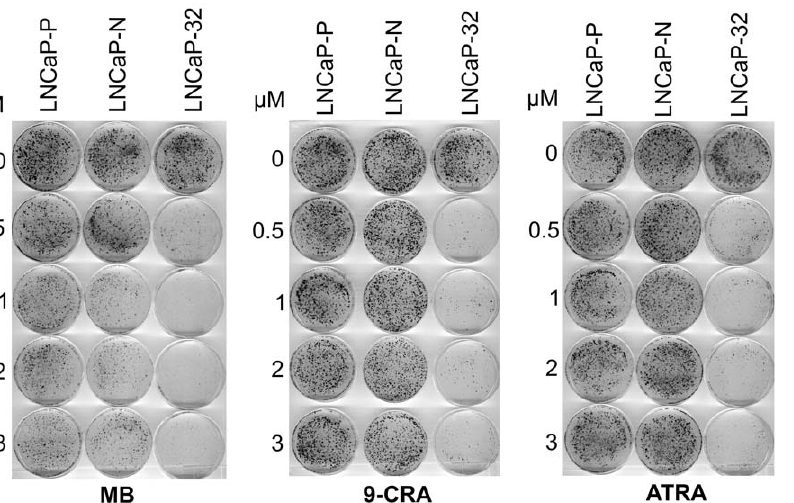
Figure 6. Connexin expression and junction formation accentuates the growth inhibitory effect of 9-CRA, ATRA and androgens in LNCaP cells. LNCaP-P, LNCaP-N and LNCaP-32 cells were seeded at a clonal density in 6 cm dishes in triplicate (2 6 10 3 cells per dish). After 24 h, cells were treated with the indicated concentrations of 9-CRA, ATRA and MB. Cells were grown until they formed visible colonies (21 d for LNCaP-P and LNCaP-N and 33 d for LNCaP-32). Medium was changed every 4 d. Colonies were fixed with formalin and stained with crystal violet as described in Materials and Methods. Note that the growth of LNCaP-32 cells is profoundly inhibited upon 9-CRA, ATRA and MB treatment as colonies are barely detectable.